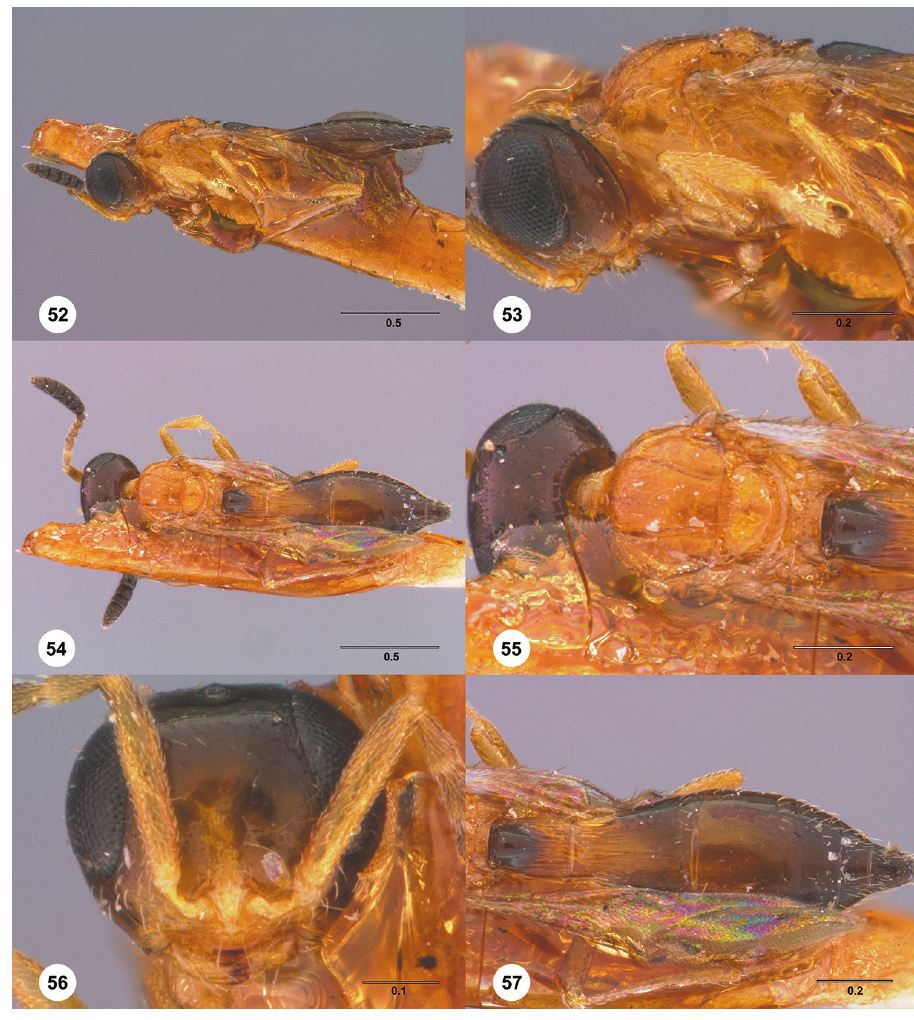
Figures 52–57. Calliscelio bisulcatus (Kieffer), female, holotype (CAS Type No. 9590). 52 Lateral habitus 53 Head and mesosoma, lateral view 54 Dorsal habitus 55 Head and mesosoma, dorsal view 56 Head, anterior view 57 Metasoma, dorsal view. Scale bars in millimeters. Color of metasoma in female: orange throughout; variably orange to pale brown. Color of metasoma in male: variably orange to pale brown. Horn on T1 in female: present as a small bulge. Sculpture of T1 horn dorsally: smooth. Sculpture of posterior margin of T1 in female: longitudinally striate throughout. Sculpture of T1 in male: longitudinally striate. Development of longitudinal striae on T2 in female: reaching the middle of T2 medially. Sculpture of T3: smooth. Shape of T6 in female: short, slightly longer than wide. Sculpture of S3: